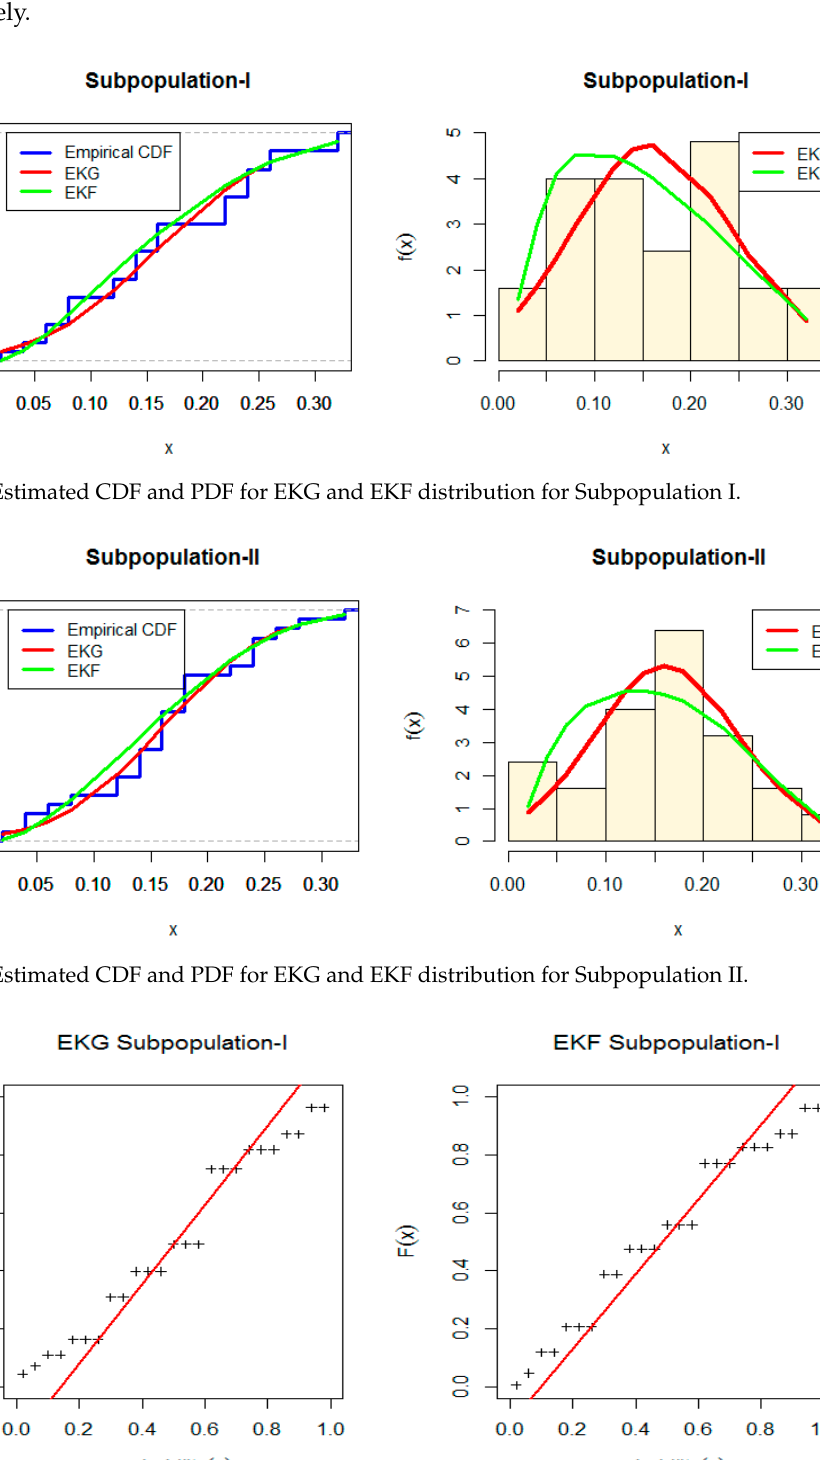
Table 6. Goodness-of-fit measures, AIC, BIC, CAIC, and HQIC for the hole diameter data.